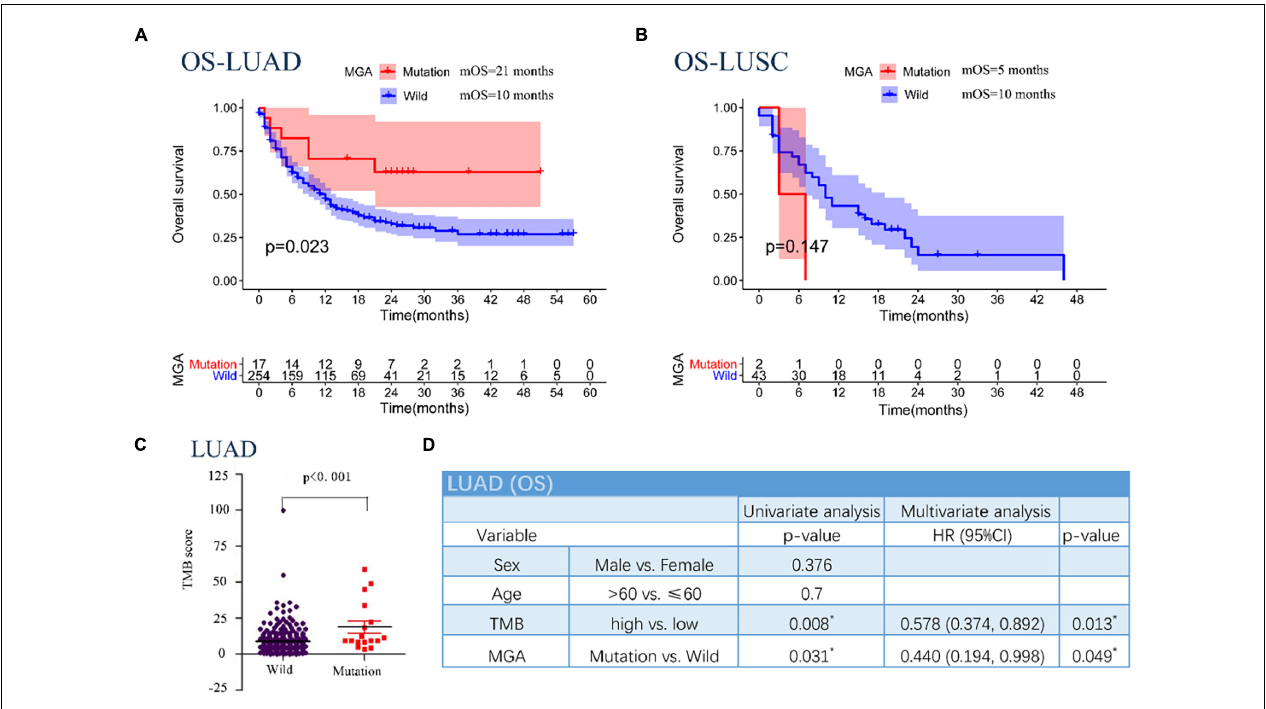
FIGURE 3 | Associations between MGA mutation and OS in different subgroups of pathologic type in patients with NSCLC in the MSKCC pan-cancer cohort. (A) Kaplan-Meier survival curves comparing OS between the MGA mutant and wild-type group in the LUAD cohort. (B) Kaplan-Meier survival curves comparing OS between the MGA mutant and wild-type group in the LUSC cohort. (C) The correlation of MGA mutation and TMB score. (D) The univariable and multivariable Cox regression in OS of LUAD patients. * P < 0.05 was considered statistically